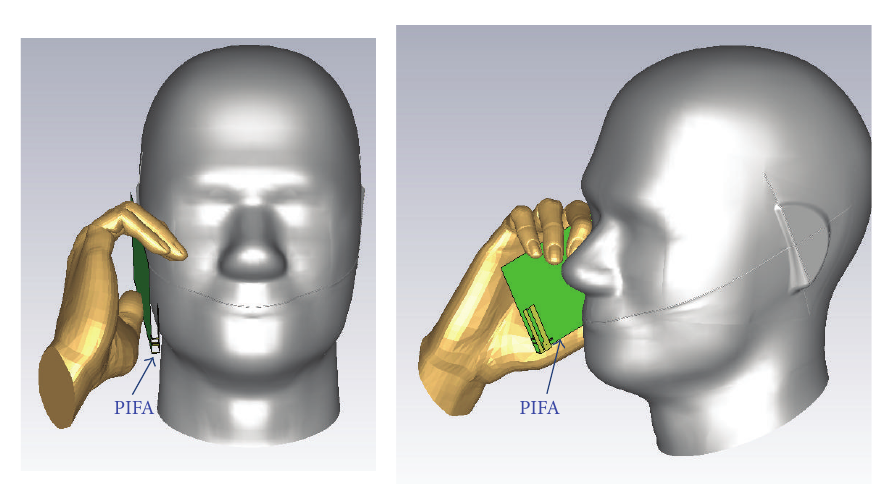
Figure 7: SAR simulation model of the proposed dual-feed PIFA.